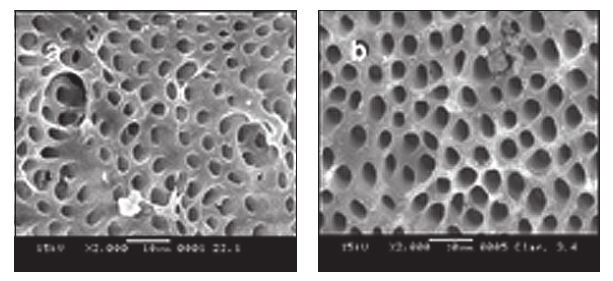
Figure 3. Scanning electron microscope micrographs showing moderate alterations of dentin surface. A: specimen treated with sodium perborate mixed with chlorhexidine (Group 2). B: specimen treated with sodium perborate mixed with hydrogen peroxide (Group